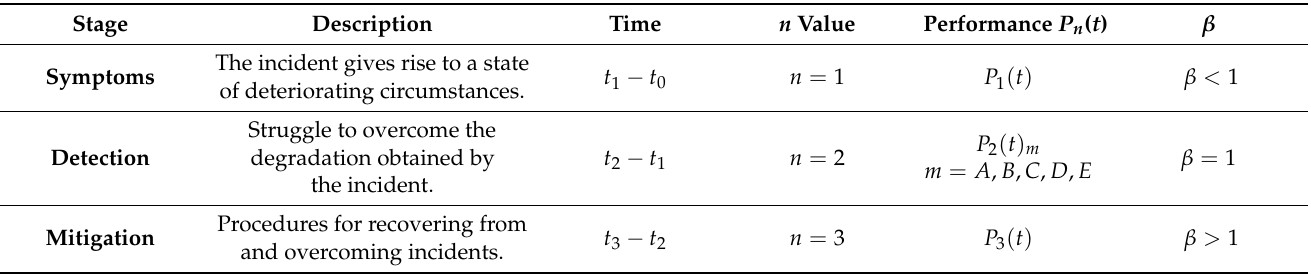
Table 7. Weibull distribution bathtub curve for maintenance.